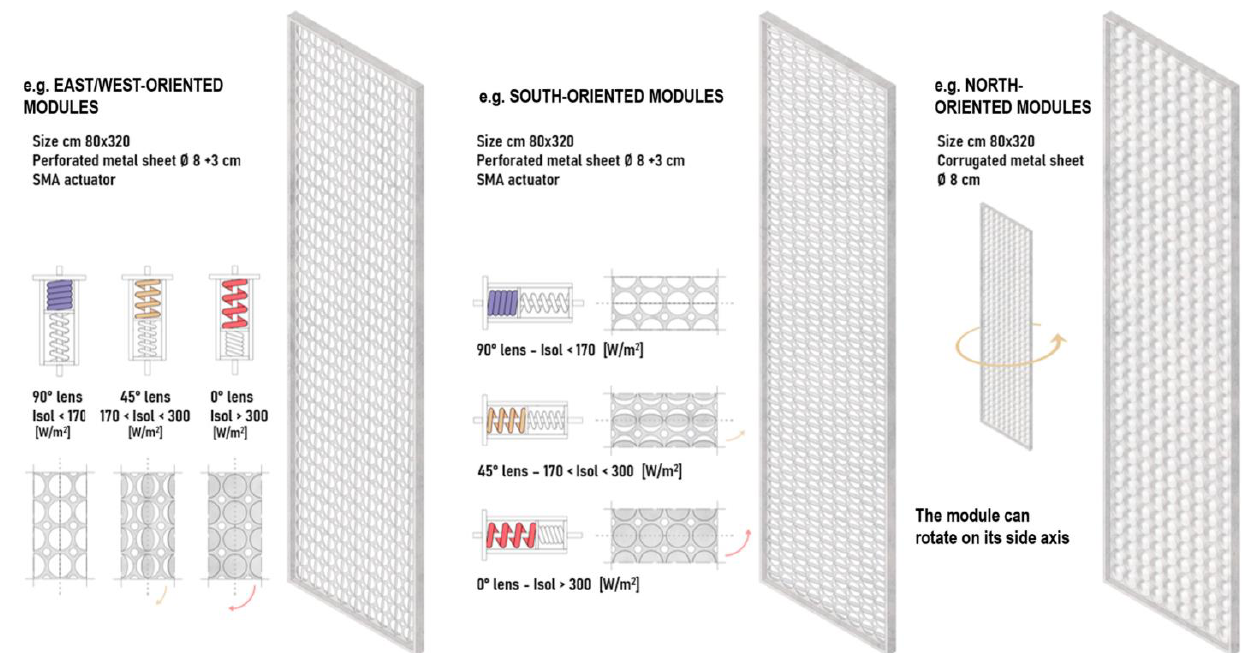
Figure 2. Dimensions of the module, of the flaps and of the activation system according to façade orientation: horizontal rotation in the case of south orientation, vertical rotation in the case of east or west orientation. (Credits: Camilla Lucchetti and Cristian Montevecchi).